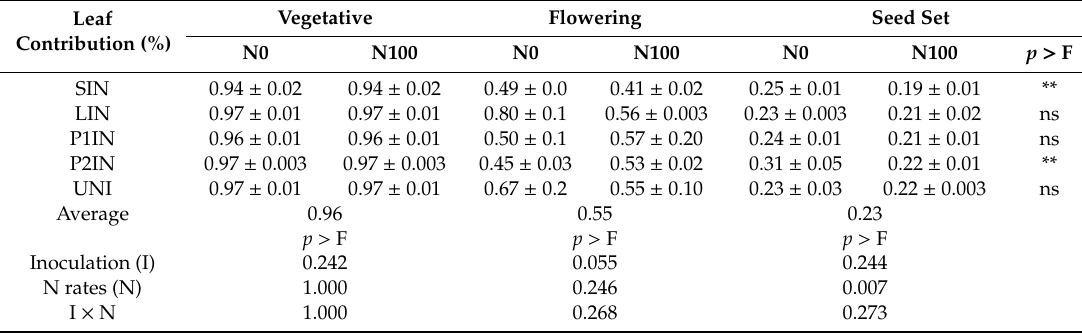
Table 1. Average ( ± standard error) leaf contribution to sulla